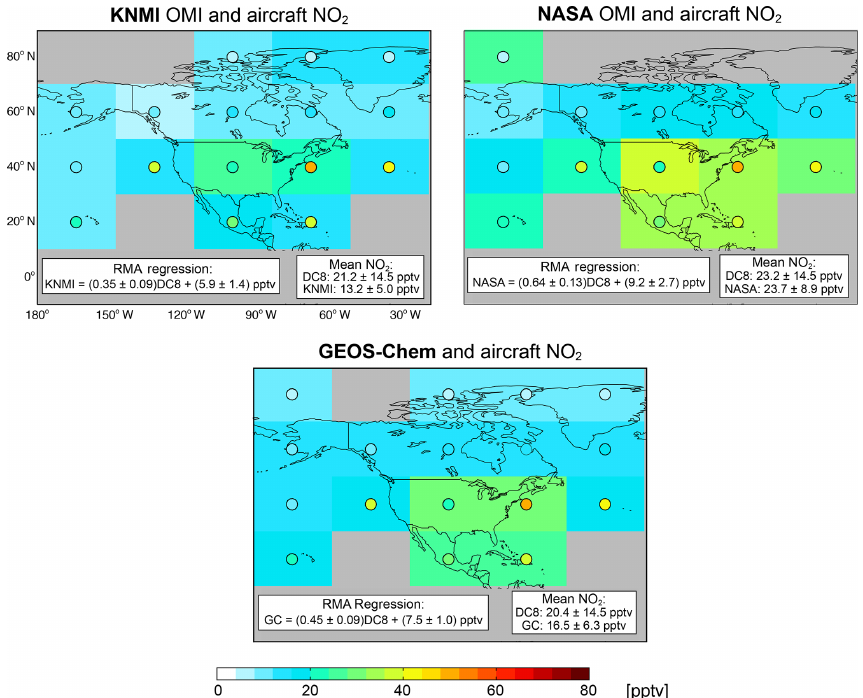
Figure 4. March–August upper troposphere NO 2 over North America. All data are at 20 ◦ × 32 ◦ . Background colors in the different panels show concentrations from KNMI, NASA, and GEOS-Chem (GC). Circles show the aircraft observations (same in all panels). Aircraft observations are for 11:00–16:00LT. The model is sampled in the satellite overpass time window (12:00–15:00LT). Model and aircraft data are at 280–450hPa and screened for stratospheric influence using ozone / CO > 1 . 25molmol − 1 . Inset boxes show reduced major axis (RMA) regression statistics and mean NO 2 for coincident grid squares. Grey grid squares indicate no coincident